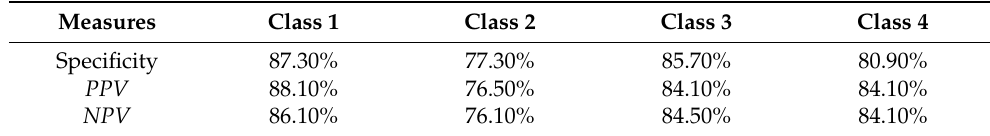
Table 11. Different measures for the DNN model on variables set